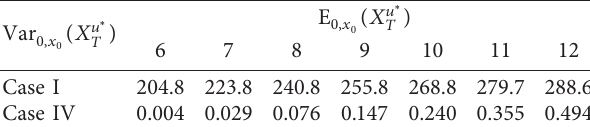
Table 2: Values of the efficient frontiers for case I and case